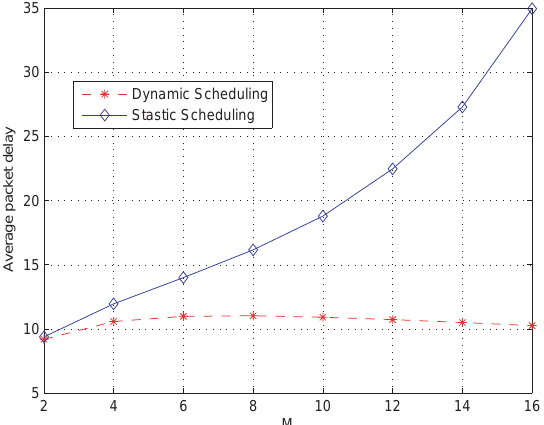
Figure 5. Average Packet Delay vs. M ( ∆ = 1 . 2 , p = 0 . 25 )